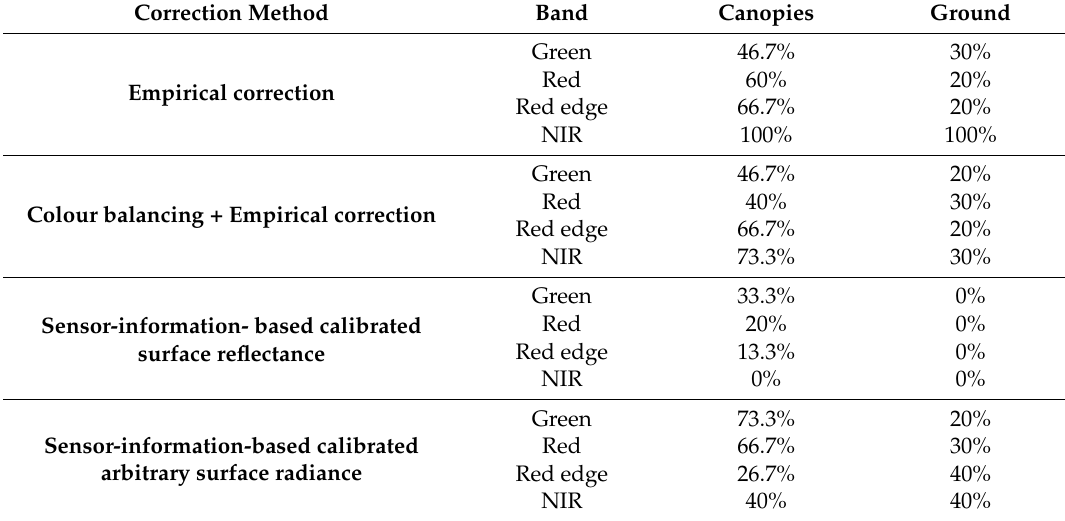
Table A7. Consistency assessment results from the box-and-whisker plot comparison between two temporally close